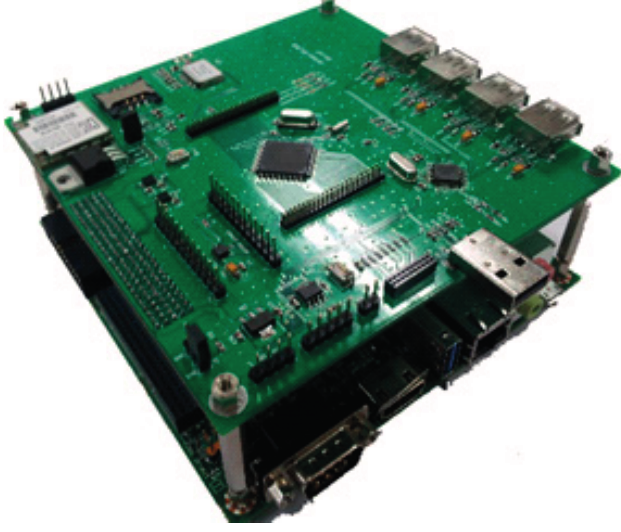
Figure 5. Prototype of the smart vehicular camera device based on NVIDIA Jetson board with the proposed extension